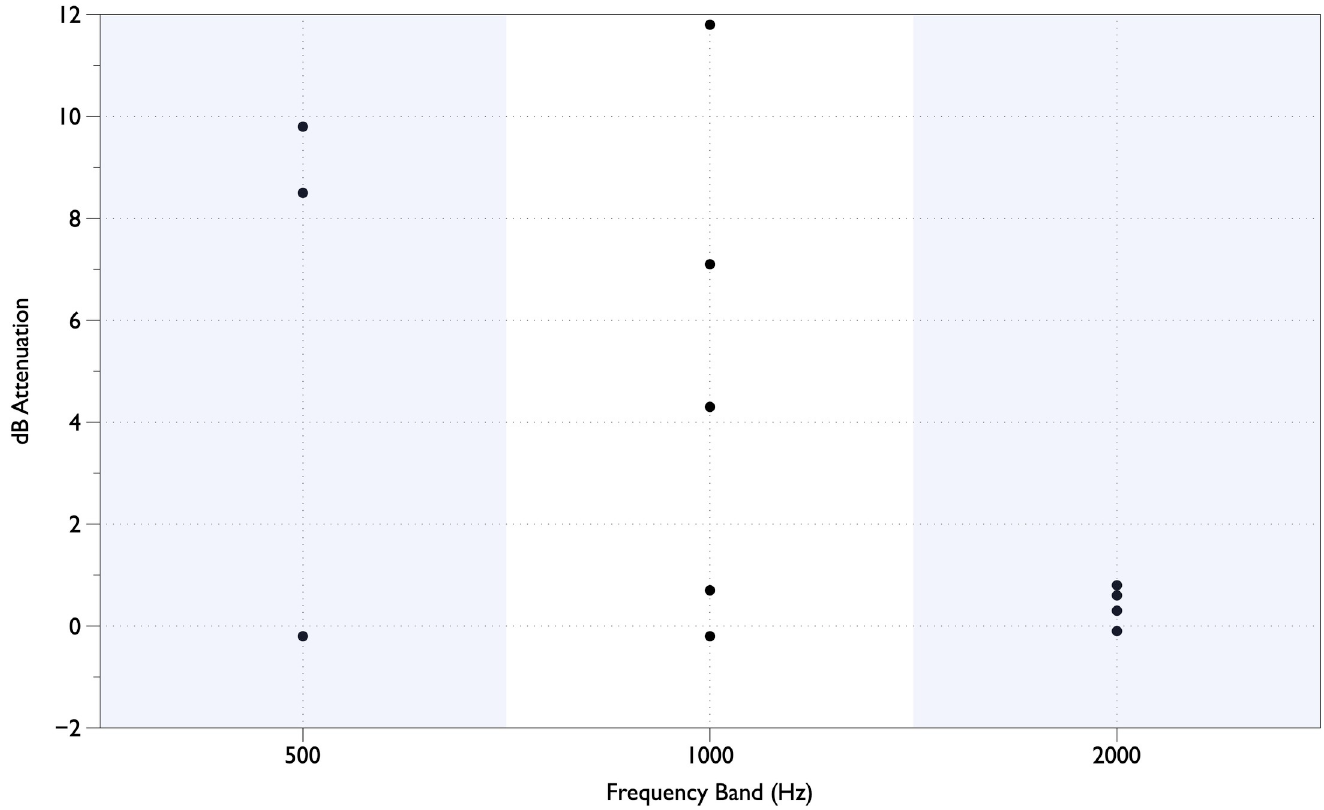
Fig 4. Amount of attenuation for all instances when the original SPL is above 40 dBA. The seven octave bands are shown on the x-axis and the A-weighted SPL is shown on the Y-axis. The results for the right and left ears are shown, labelled “R” and “L.” The square represents the unattenuated sound and the top of the gray bar represents the attenuation achieved by the Neoasis ™ system. The test sequence used comprised a high priority patient monitor alarm, a bubble CPAP device operating, and hospital environmental noise.